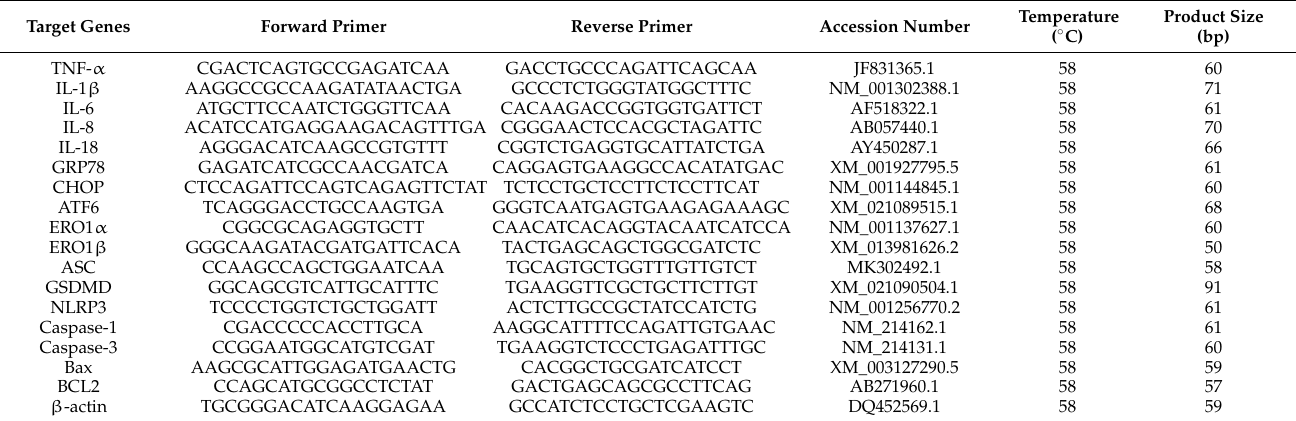
Table 2. Primer sequences used for real-time